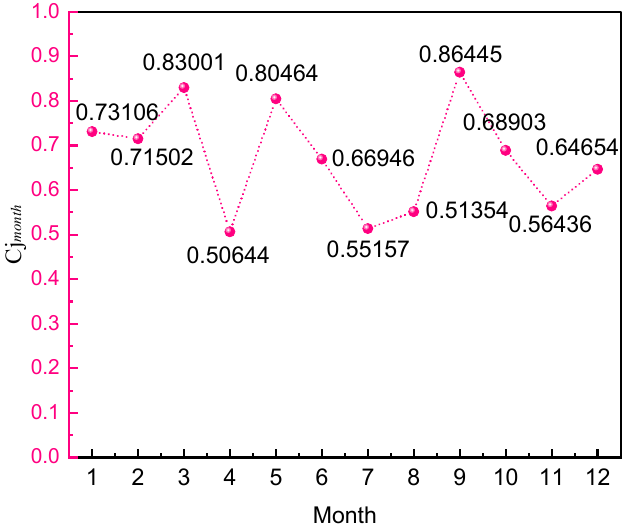
Figure 9. Curve of annual systematic risk factor.